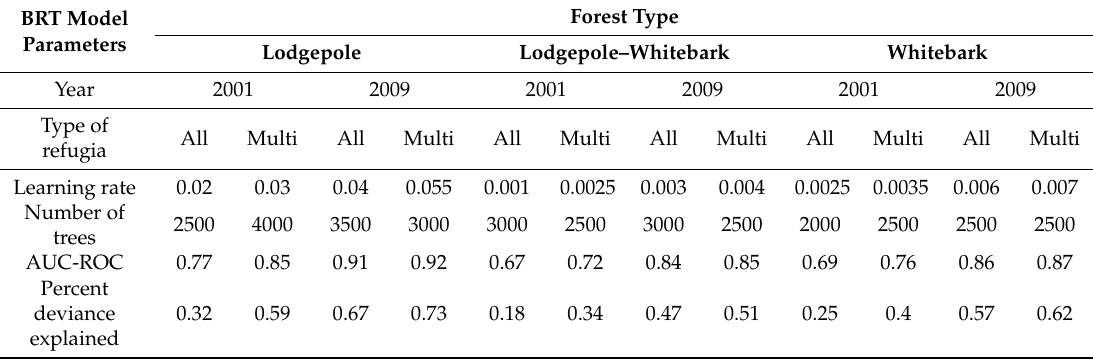
Table A3. Boosted regression tree (BRT) model results relating probability of refugia to landscape characteristics, comparing models of all refugia (single-cell and multi-cell) to models only for multi-cell